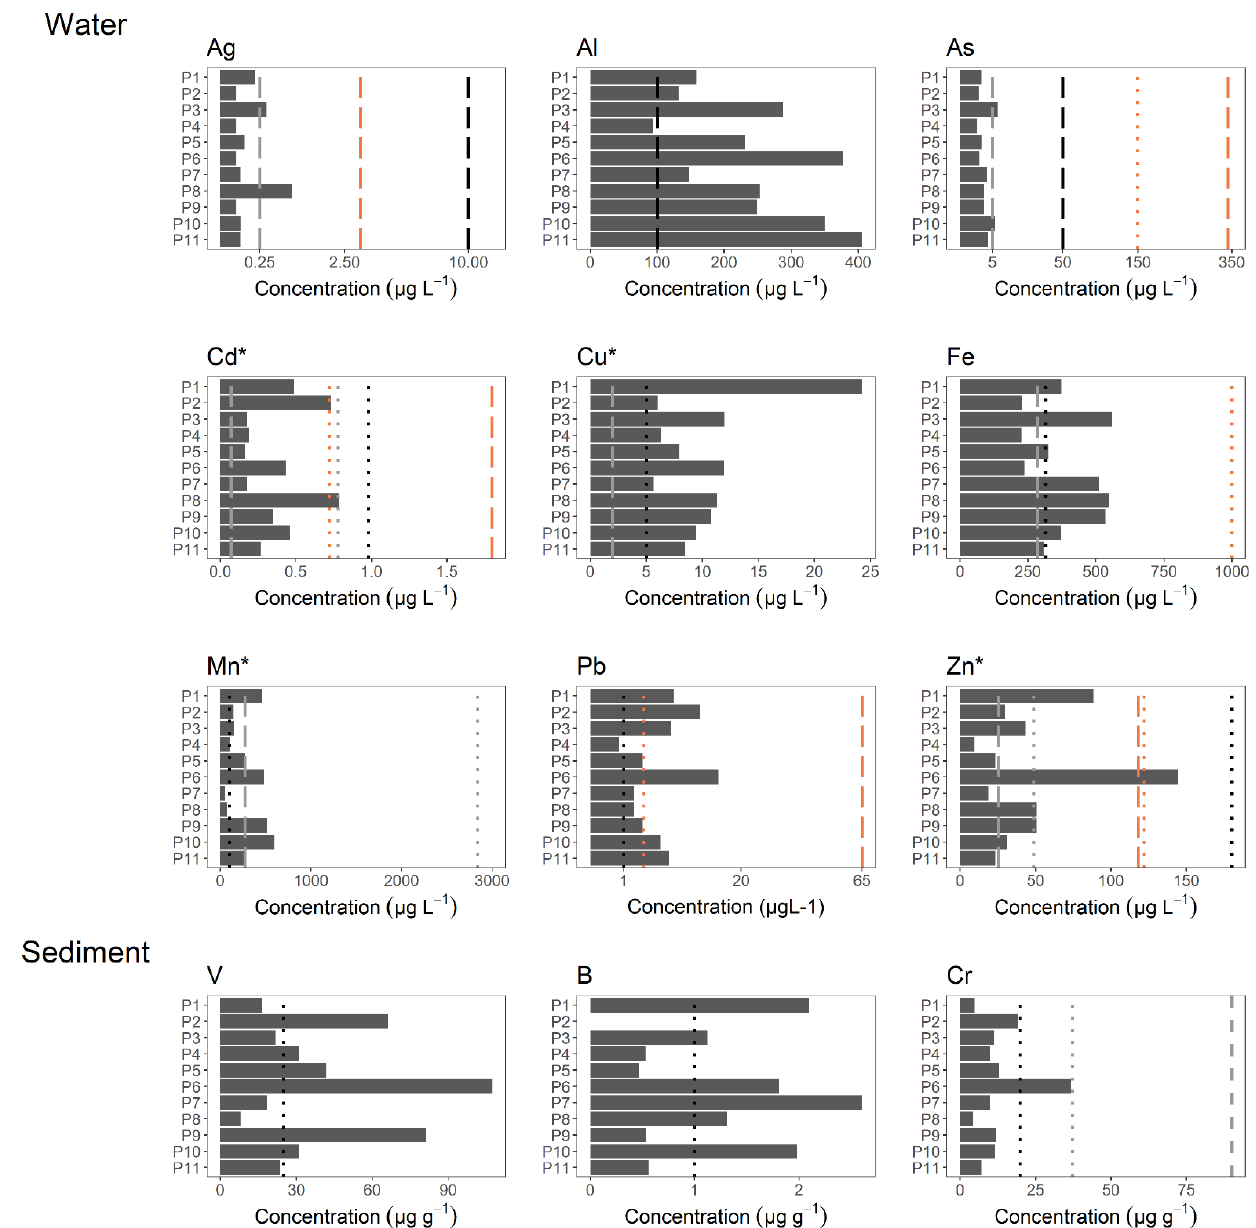
Figure 2. Average metal concentrations in water ( µ g L − 1 ) and in sediment samples ( µ g g − 1 ). Only metals that were detected above permissible limits are shown. For water samples, vertical lines indicate the limits established by the Canadian Environmental Quality Guidelines for the Protection of Aquatic Life [32] for short- (gray dotted lines) and long-term effects (gray dashed lines), and the Ecuadorian legislation TULSMA (black dotted lines) and Water Quality Criteria for the Protection of Aquatic Life [31] for acute (brown dashed lines) and chronic (brown dotted lines) effects. For sediment samples, vertical lines indicate the limits established by the Ecuadorian legislation [30] (black dotted lines) and the threshold effect level (TEL; gray dotted lines) and the probable effect level (PEL; gray dashed lines), as defined by CCME (2002). * The highest CCME short- or long-term thresholds are shown. Actual threshold values can be found in the Table S3 of the Supplementary Materials.